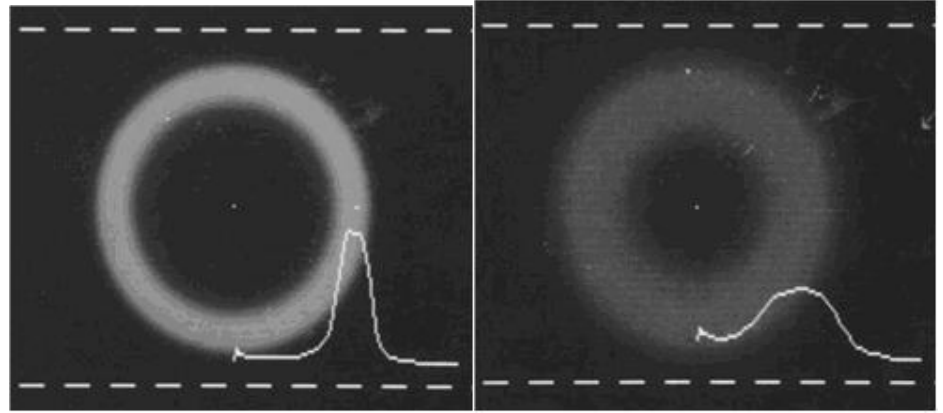
Figure 8. The 2-D image and the horizontal intensity profile of the far-field pattern measured at the center before (a) and after (b) the presence